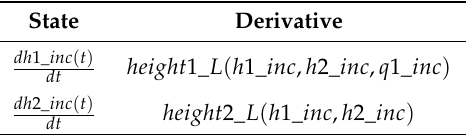
Table 1. Differential equations of linearized system (linear